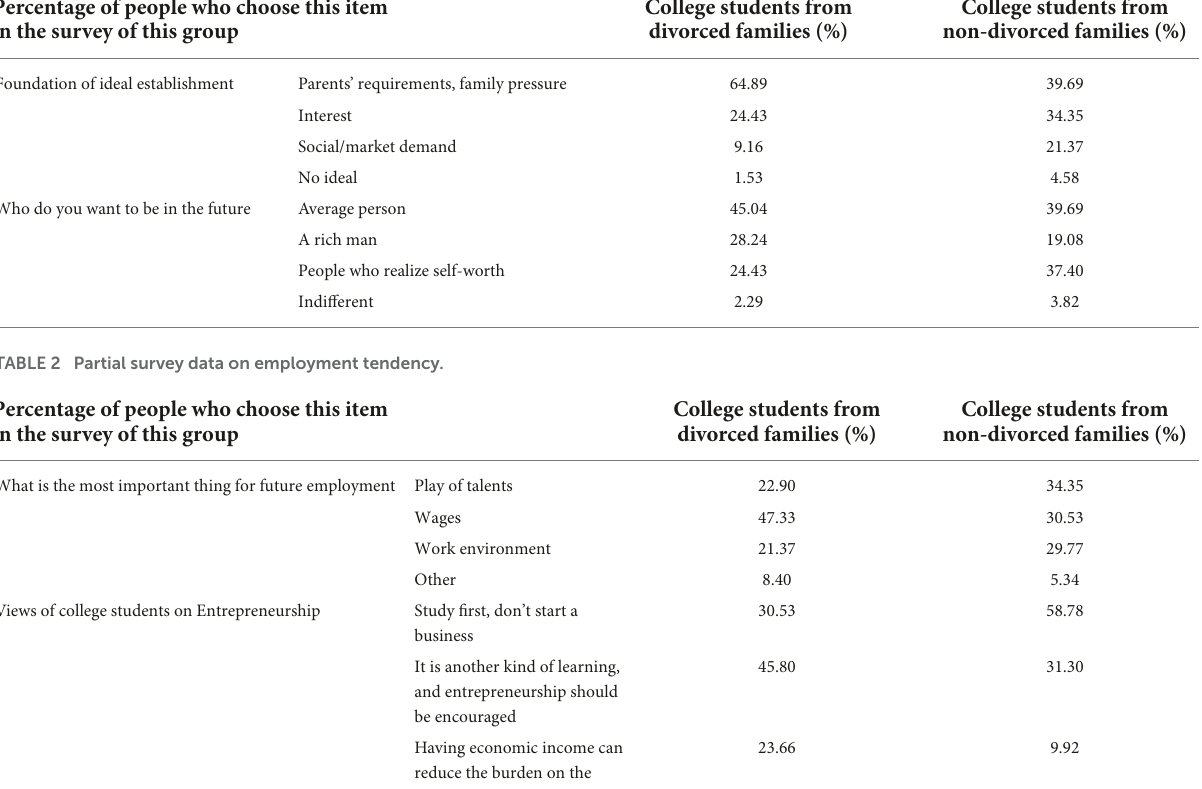
TABLE 1 Some survey data on ideals and beliefs.